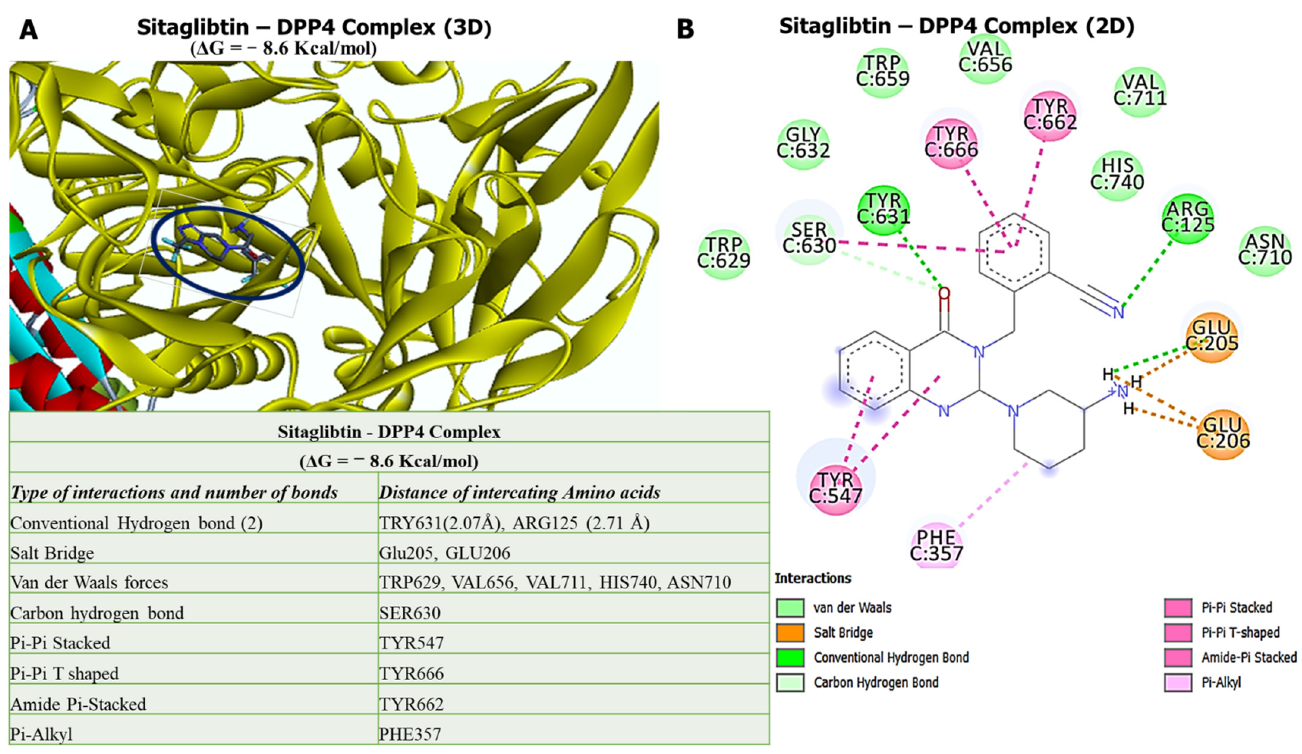
Figure 6. Ligand–receptor interaction results of sitagliptin with DPP4. ( A ) Three-dimensional (3D) representation of sitagliptin in complex with DPP4 with the highest binding energy of − 8.6 kcal/mol. ( B ) Two-dimensional (2D) representation of sitagliptin in complex with DPP4 , showing interactions with two conventional H-bonds, with interactions further stabilized by different amino acids around the sitagliptin backbone. The accompanying table shows summary results of the analysis.